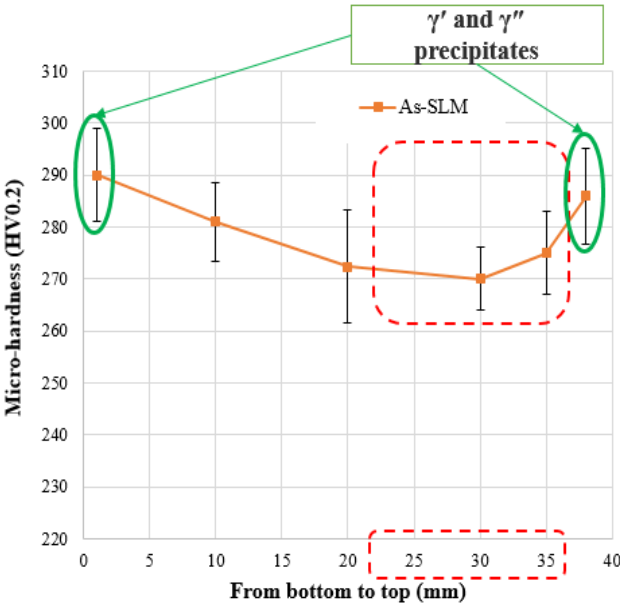
Figure 7. Variation of the micro-hardness measured from bottom to the top of as-SLM sample.